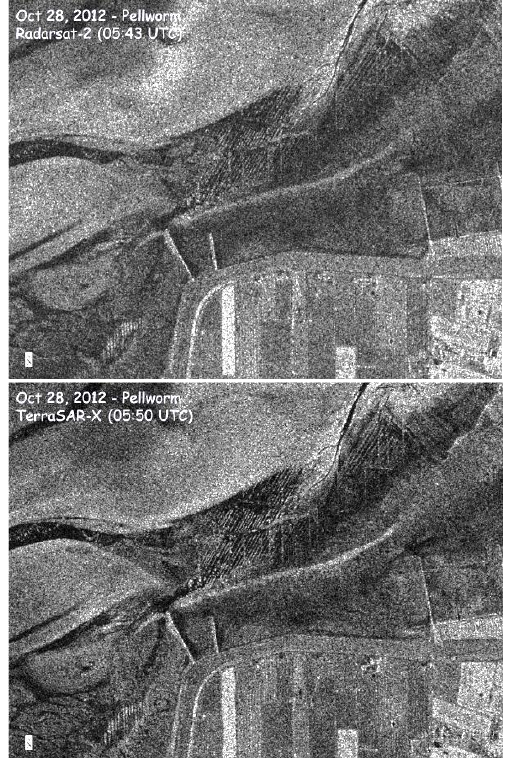
Figure 4. Radarsat-2 (upper) and TerraSAR-X (lower) SAR images of the same spot, north off Pellworm, acquired on 28 October 2012. The diagonal lines in the images’ centers are remnants of historical